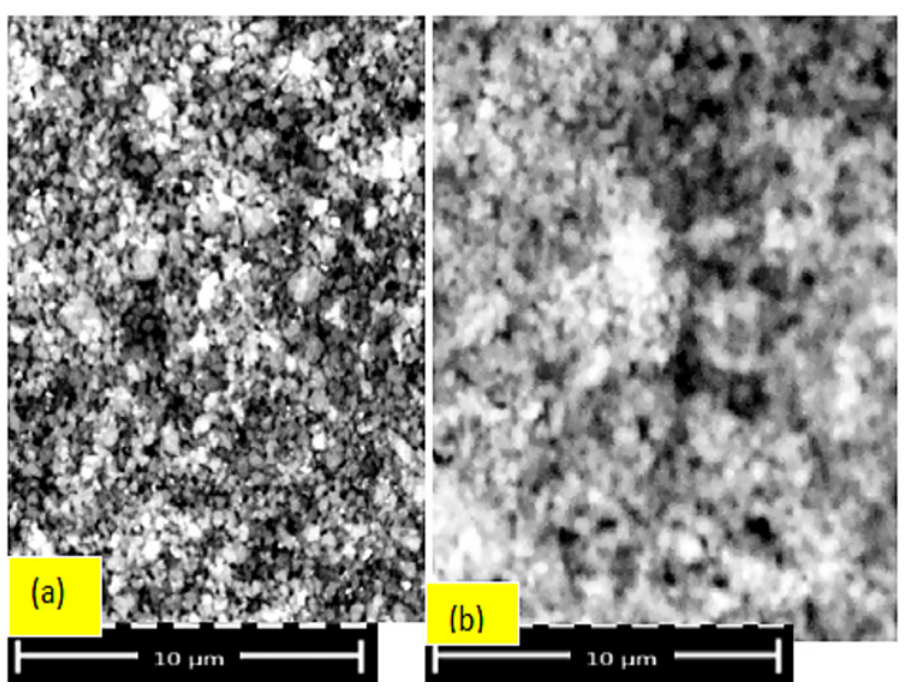
Fig 8. SEM images of the (a) fresh and (b) spent Fe-ZSM-5.